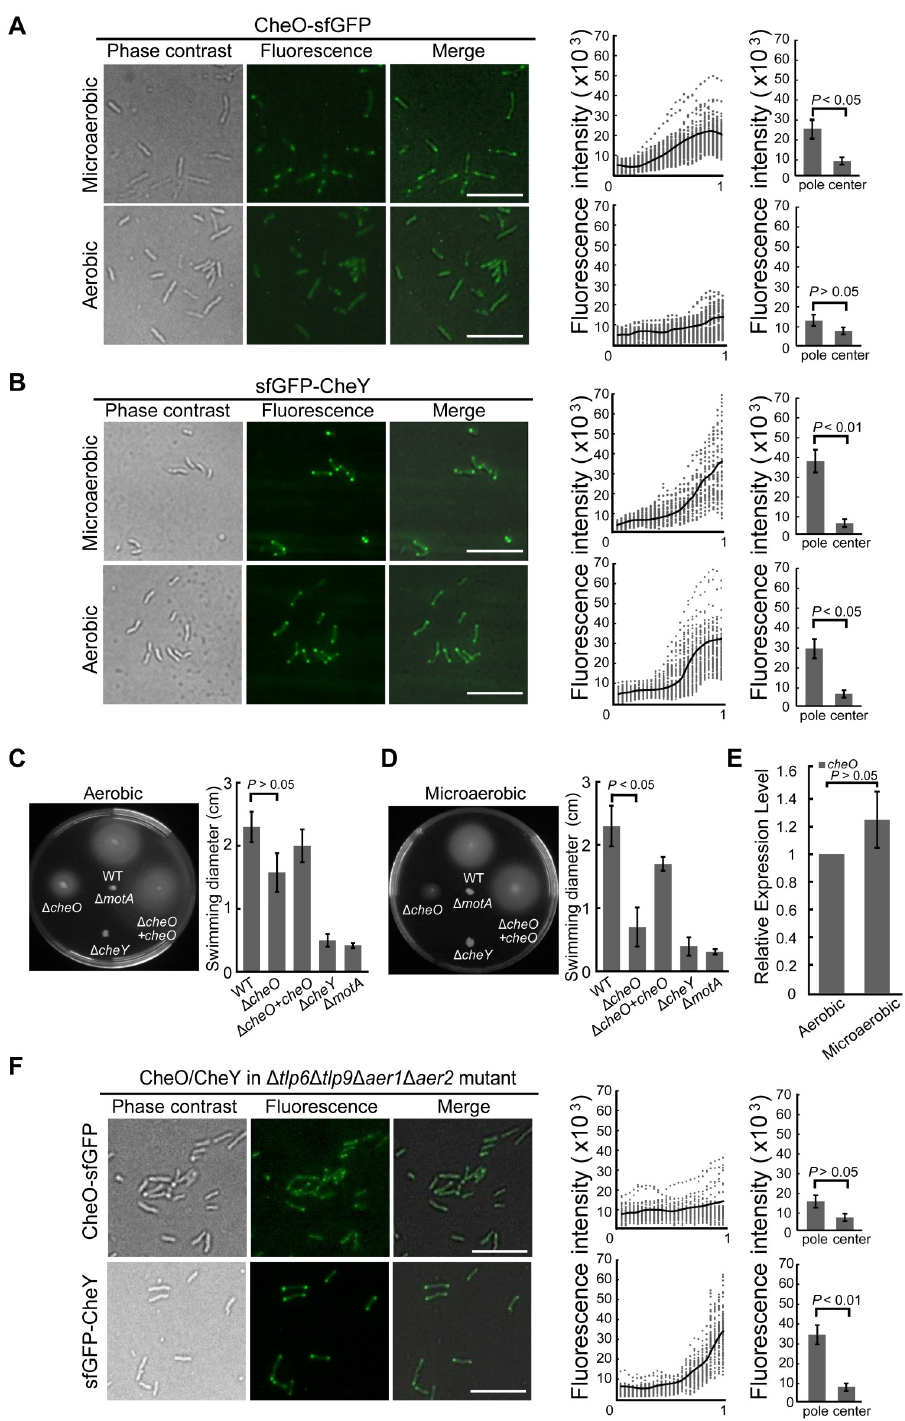
Fig 3. The oxygen level and Tlps in energy taxis influence CheO localization. (A-B) Different oxygen level alters CheO-sfGFP localization and sfGFP-CheY as a control. (C-D) Soft agar motility assay of C . jejuni wild-type and mutant strains in aerobic/microaerobic conditions. Histogram graph shows the diameter of the swimming zone of mutant strains in comparison with the wild-type, with Δ cheY and Δ motA mutants as negative controls. Data are shown as the mean ± standard deviation (n = 6). P -values derived from Student’s t -test are shown on the column. (E) Transcription profile of cheO after growth in aerobic or microaerobic conditions for 24 hours. Data represent the average of three experiments and error bars show SD. (F) Localization of CheO-sfGFP and sfGFP-CheY in Δ tlp6 Δ tlp9 Δ aer1 Δ aer2 mutant. The scatter plot graph and histogram are the same as Fig 2.